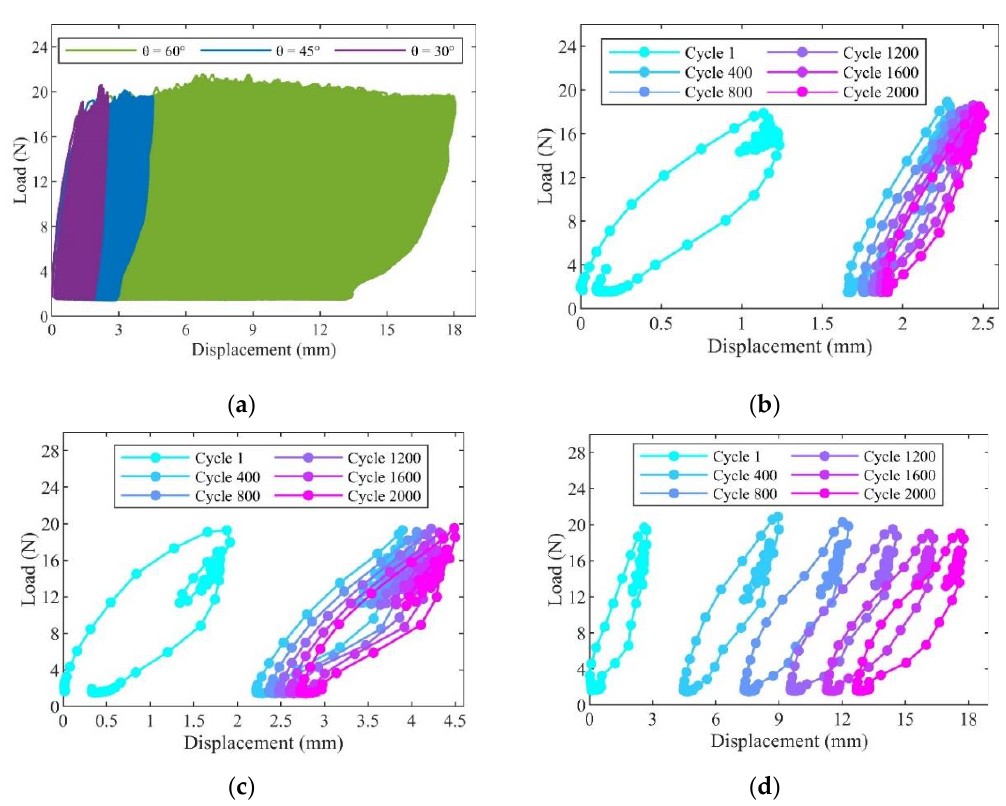
Figure 11. Displacement load hysteresis curves under variable tension angles: ( a ) total; ( b ) θ = 30 ◦ ; ( c ) θ = 45 ◦ ; ( d ) θ = 60 ◦